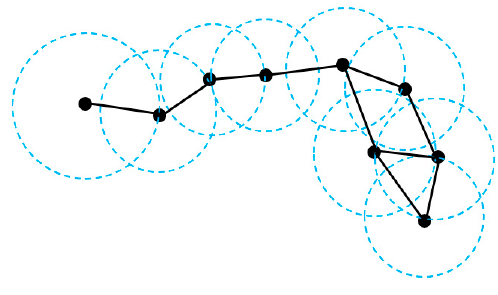
Figure 3. Example of a Sphere-of-Influence graph (SIG).